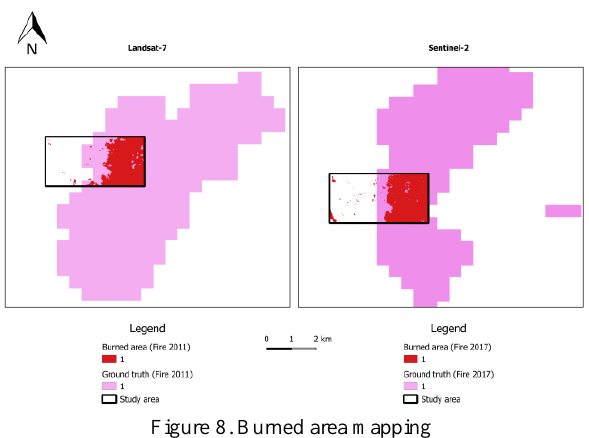
Figure 6. Fuel models by Prometheus (Arroyo et al. 2006).